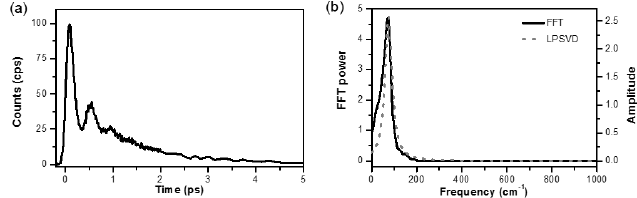
Fig. 2. (a) Time-resolved fluorescence at a fixed wavelength (350 nm). (b) Frequency spectra obtained by fast Fourier Transform (solid line) and linear prediction singular value decomposition (LPSVD) (dashed